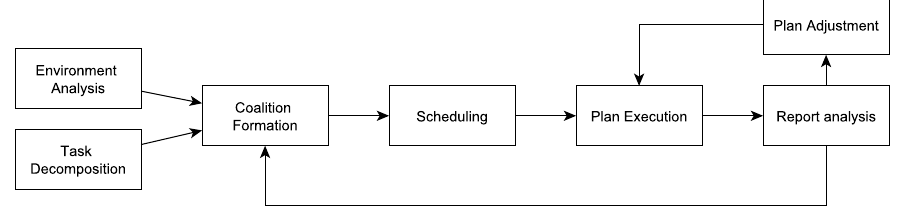
Figure 2. Scheme of joint task